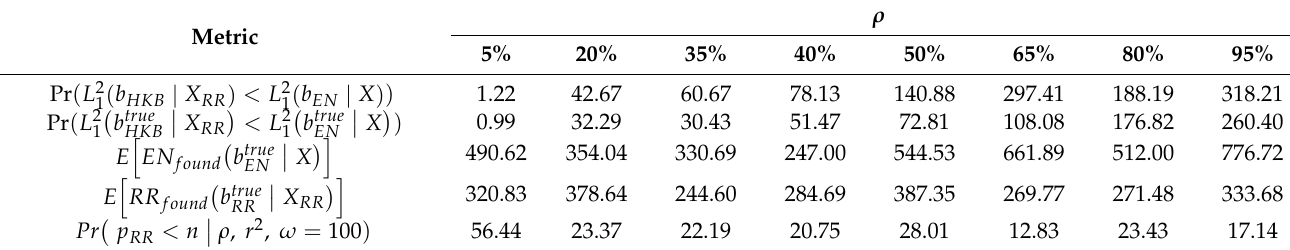
Table 7. SNRs by ρ over large r 2 values, where ω =